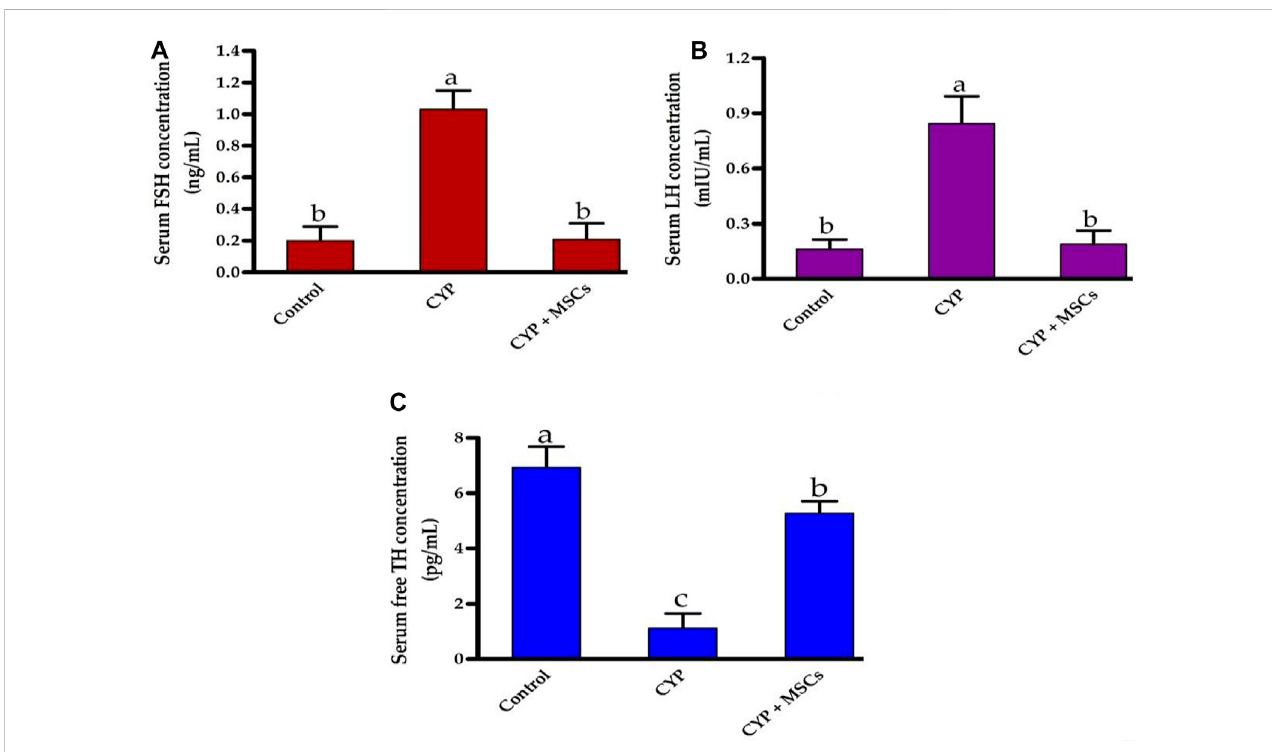
FIGURE 1 In fl uences of CYP with/without MSCs transplantation on serum hormones concentrations; (A) serum FSH, (B) serum LH, and (C) serum free TH. Data described as mean ± SD (n = 6). DMRTs show that bars with various letters are substantially different at p =